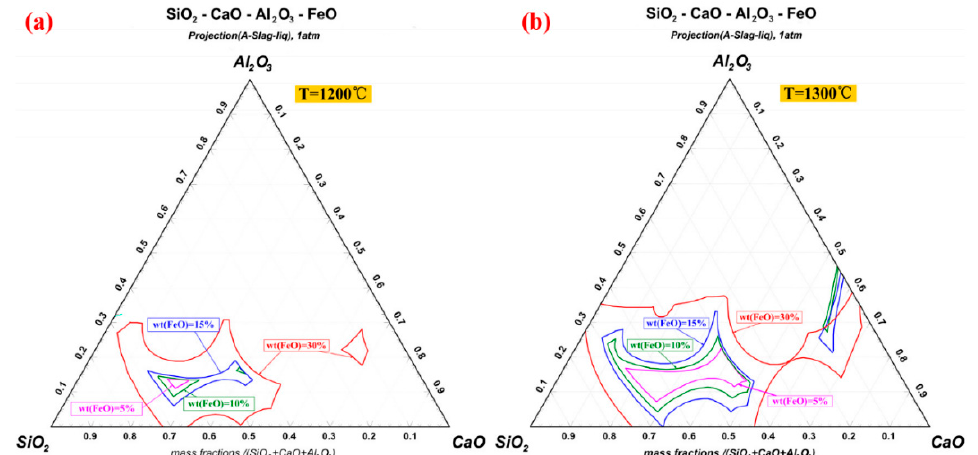
Figure 10. The phase diagram, including ( a ) phase diagram of SiO 2 -CaO-Al 2 O 3 -FeO (1200 °C); ( b ) phase diagram of SiO 2 -